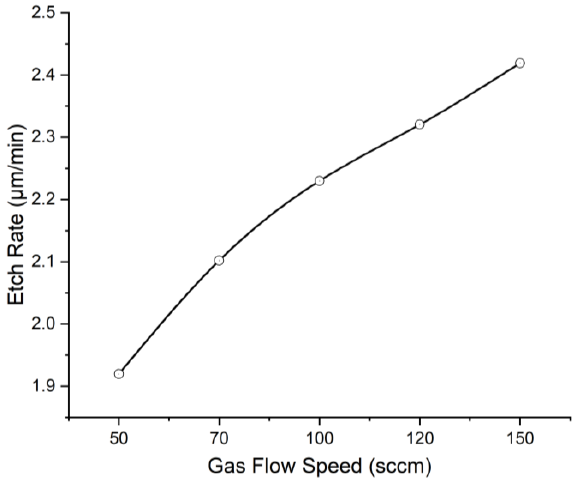
Figure 6. The relationship between etch rate and gas flow speed under 2000 W ICP power, 600 W RF power, and 10% CHF 3 gas composition.